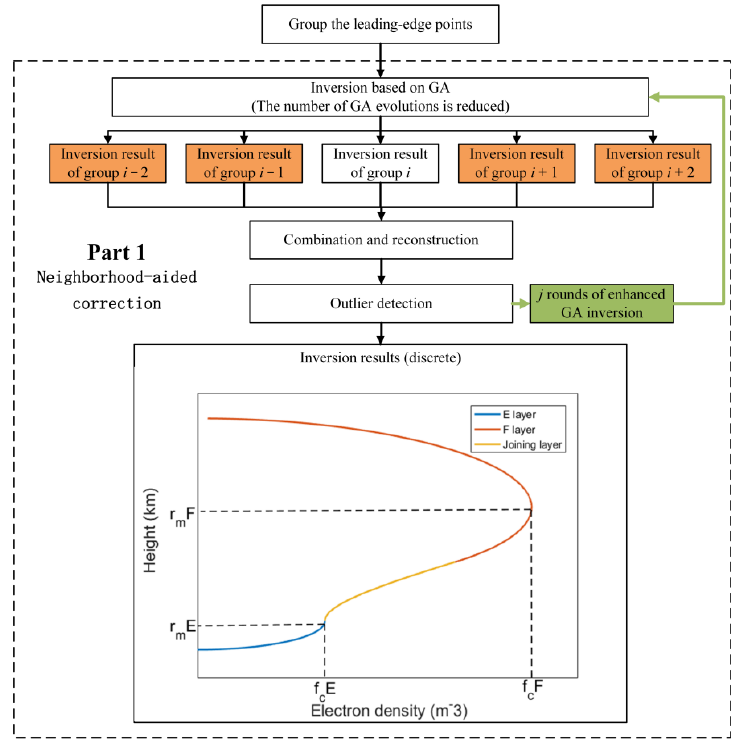
Figure 1. Neighborhood-aided correction algorithm.